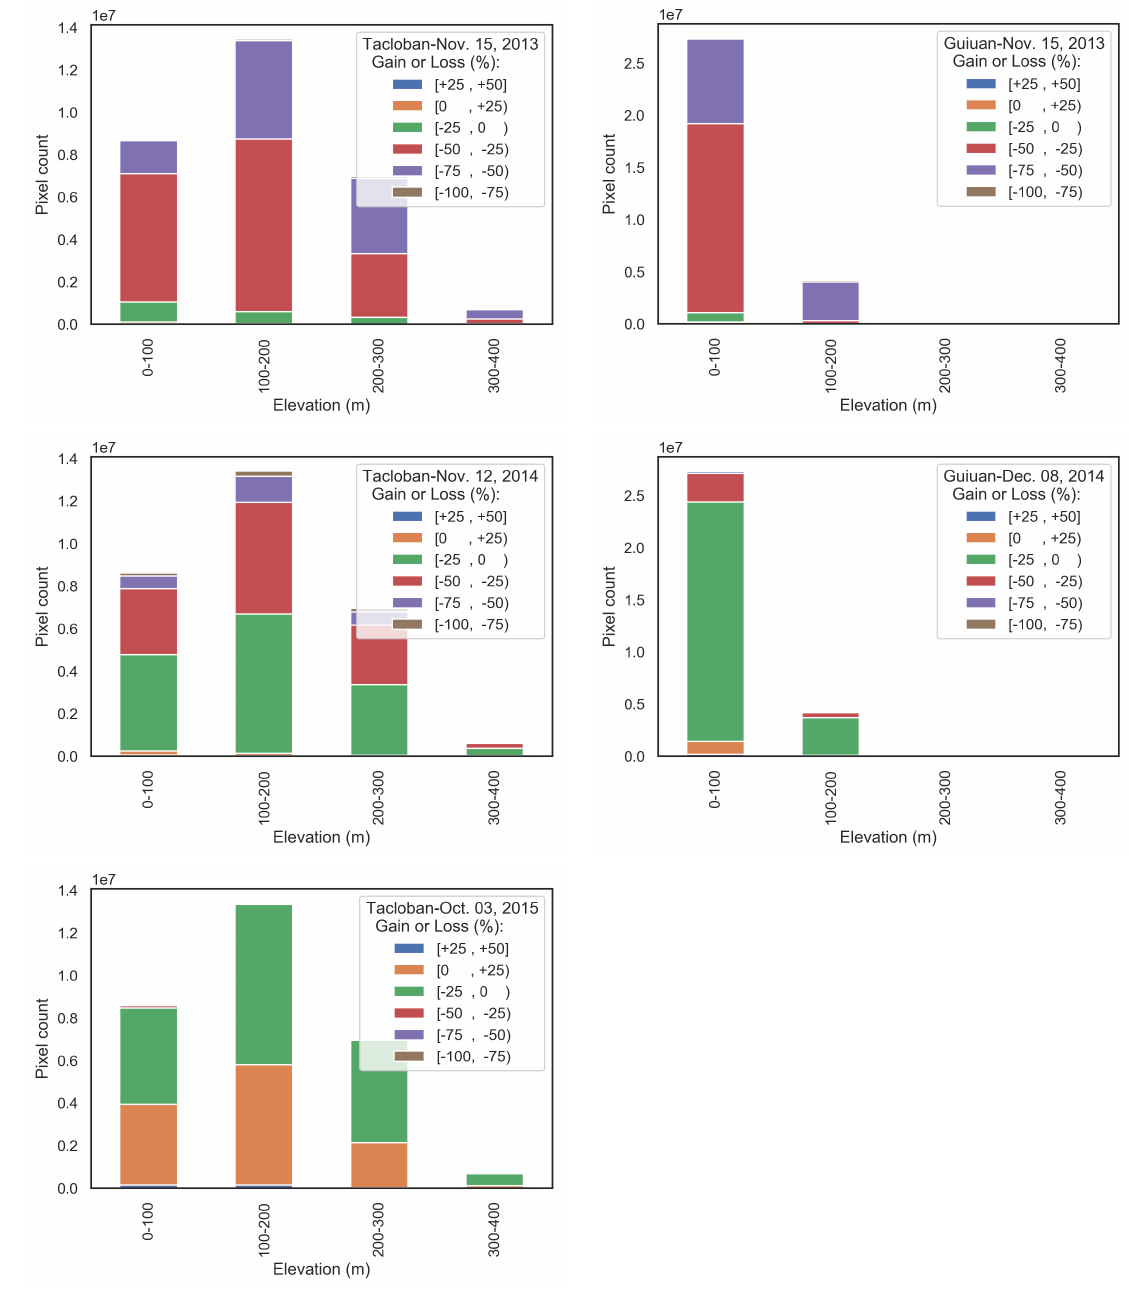
Figure 8. The relationship between elevation and biomass gain/loss of Tacloban ( left ) and Guiuan ( right ) study sites, with the positive and negative percentages indicate a gain and loss in biomass,